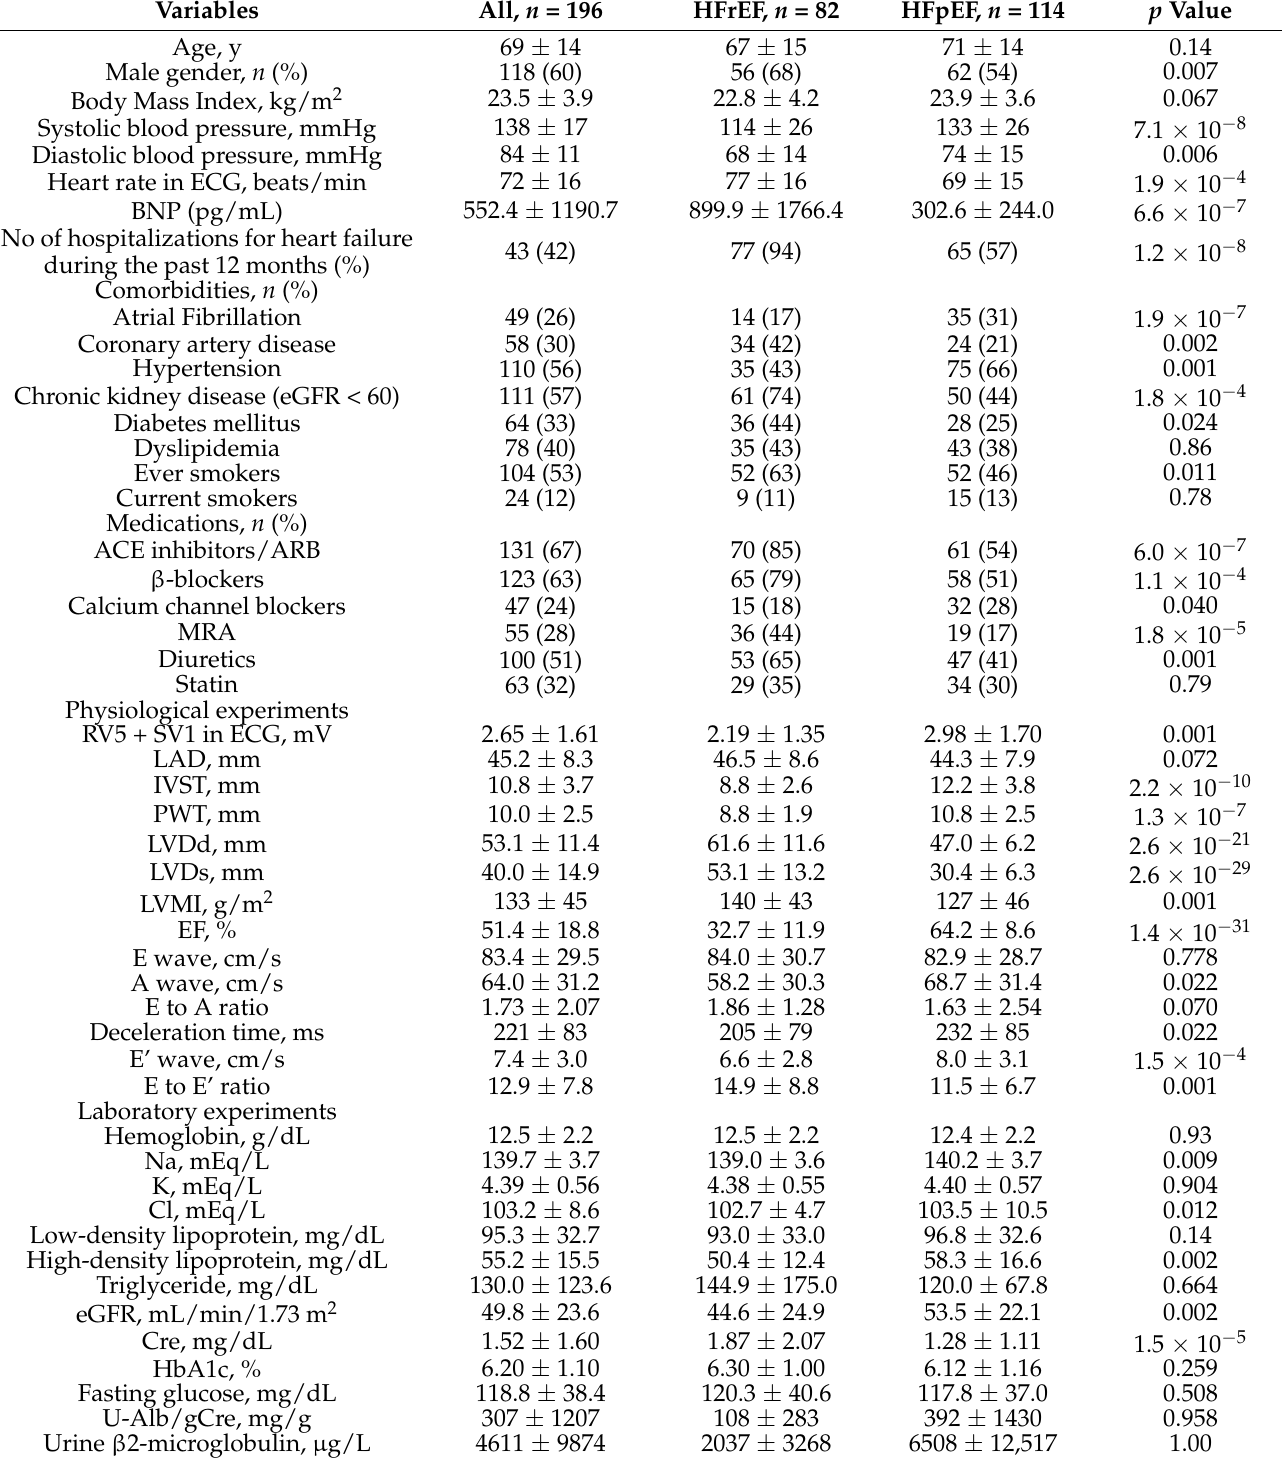
Table 1. Patient